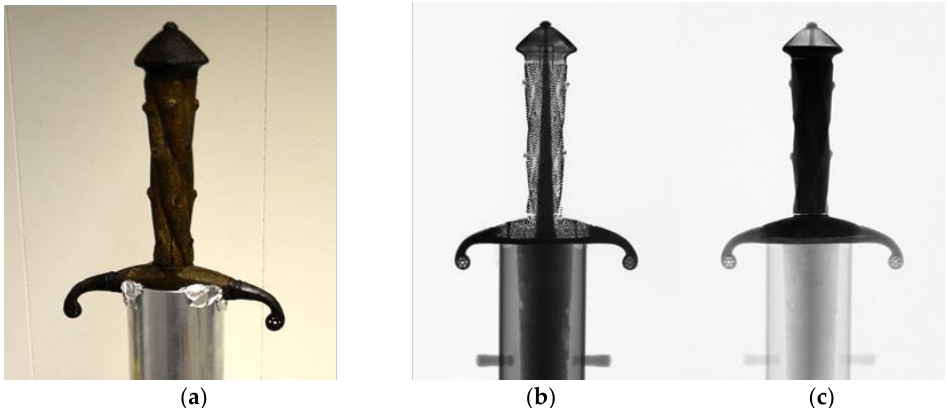
Figure 5. A picture of the sword mounted for the scan of the hilt ( a ). The projections using 150 kV X-rays ( b ) and thermal neutrons ( c ) clearly show the complementarity of the two modalities for this specimen.